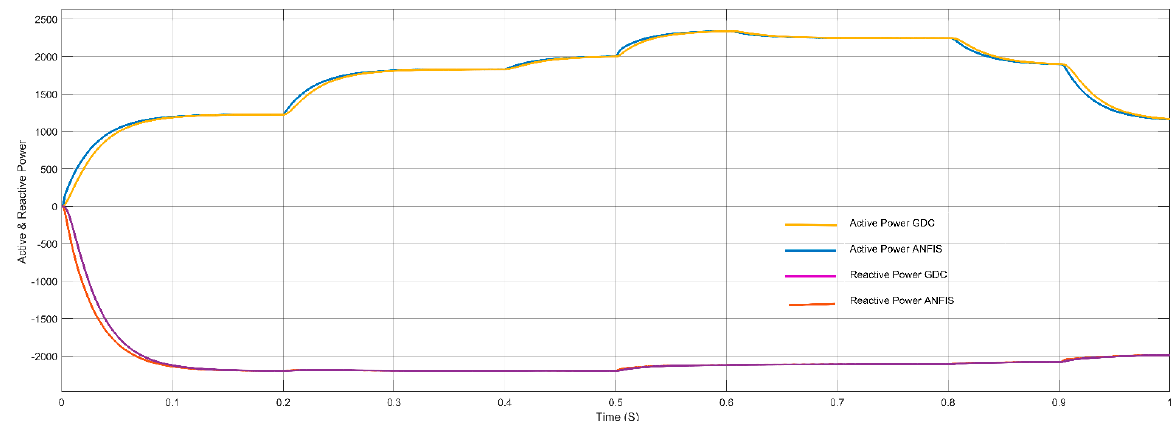
Figure 18. Comparison of Frequency GDC vs. ANFIS.